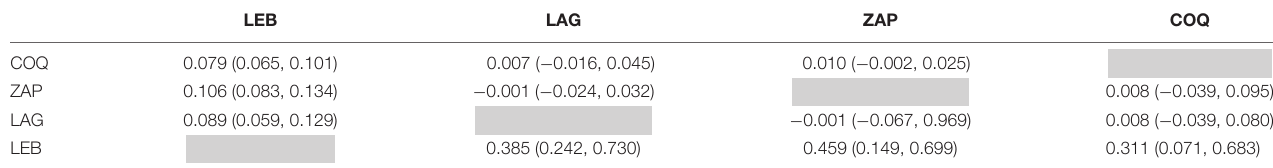
TABLE 4 | Pairwise differentiation estimators between Genypterus chilensis localities in the coast of Chile.